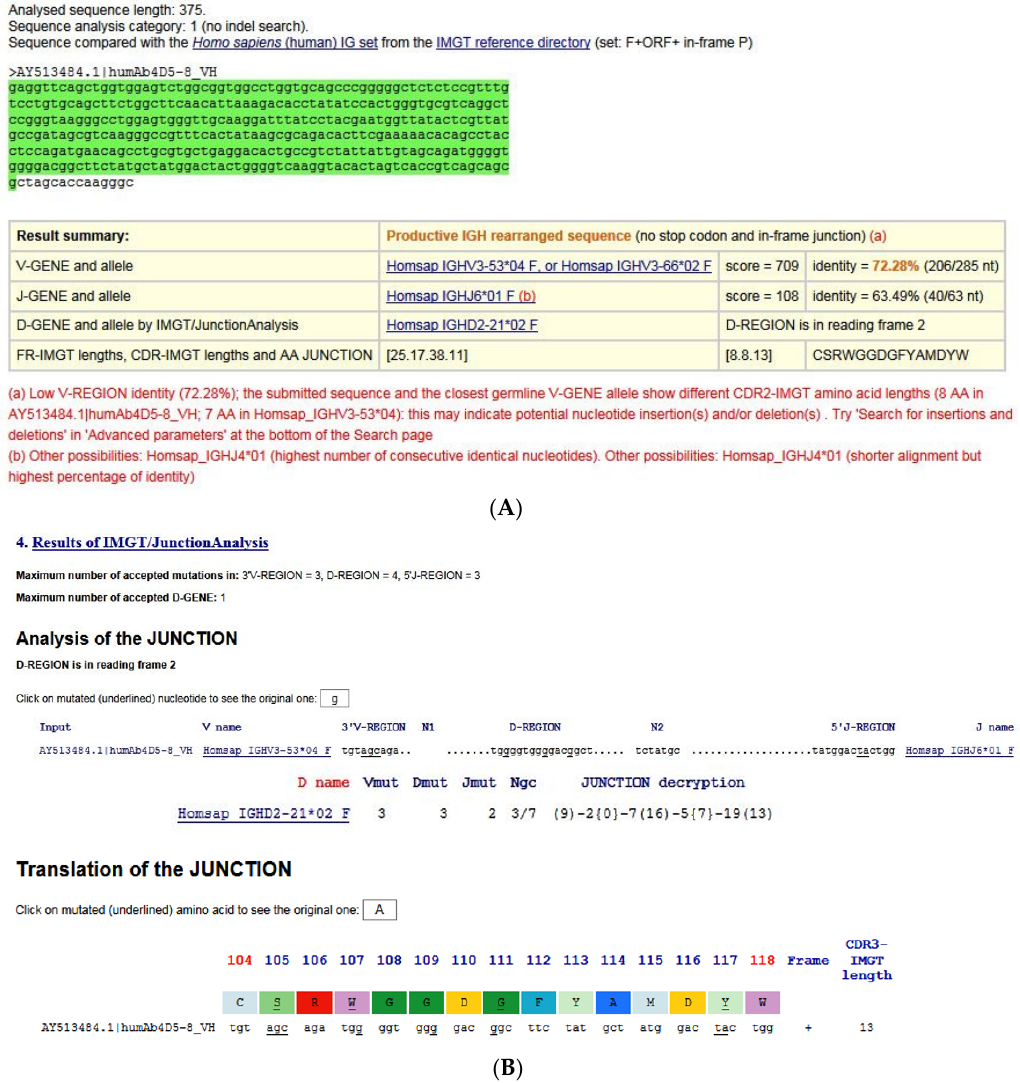
Figure 26. IMGT/V ‐ QUEST. ( A ). Result summary. AY513484 is the nucleotide sequence of the VH Figure 26. IMGT / V-QUEST. ( A ). Result summary. AY513484 is the nucleotide sequence of the VH domain of humAb4D5 ‐ 8 (trastuzumab) (identified in IMGT/LIGM ‐ DB [54,55] by the clone name). domain of humAb4D5-8 (trastuzumab) (identified in IMGT / LIGM-DB [54,55] by the clone name). Comments in red are added automatically by the IMGT/V ‐ QUEST tool. The sequence identified by Comments in red are added automatically by the IMGT / V-QUEST tool. The sequence identified IMGT/V ‐ QUEST as containing a V domain in the user sequence, and therefore analysed by the tool, is displayed with a green background. ( B ). Results of IMGT/JunctionAnalysis. The JUNCTION